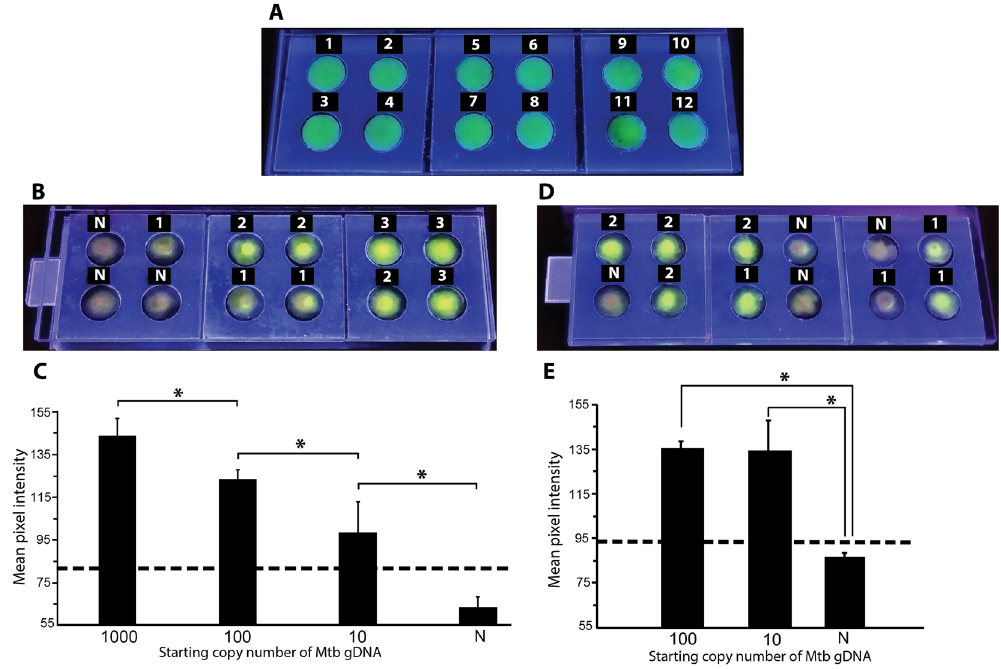
Figure 5. LAMP in FLIPP-NAAT and end-point fluorescence detection. ( A ) Testing uniformity of field in FLIPP-NAAT. Numbers on each reaction zone mark the 12 replicates. The mean intensity for signals from the 12 reaction zones was 160 with a coefficient of variation of only 5.4%. ( B ) Cell phone image of FLIPP-NAAT after 5 minutes of addition of SYBR Green I dye for fluorescence detection. Numbers on top of each reaction zone indicate log 10 of Mtb gDNA starting copy number. N – no template control. ( C ) Mean pixel intensity of green color for the different starting copy numbers. The mean intensity of each starting copy number was statistically different from that of others ( * P < 0.05; N = 3). ( D ) LAMP reactions in FLIPP-NAAT in presence of 3.1 * 10 3 copies of human gDNA. Numbers on top of each reaction zone indicate log 10 of Mtb gDNA starting copy number. N – no template control containing only human gDNA. ( E ) Mean pixel intensity of green color for the different starting copy numbers. The mean intensity of 100 and 10 copy number was statistically different from that of the negative controls ( * P < 0.05; N = 3). The one drop out for 10 copies (second reaction zone from the right in the bottom row, Panel D) was not included for the intensity analysis as it was a false negative. The dashed line represents the threshold value of ( µ N + 3 σ N ). Samples with intensity below the threshold were considered as TB negative while samples with green color intensity above the threshold were considered as TB